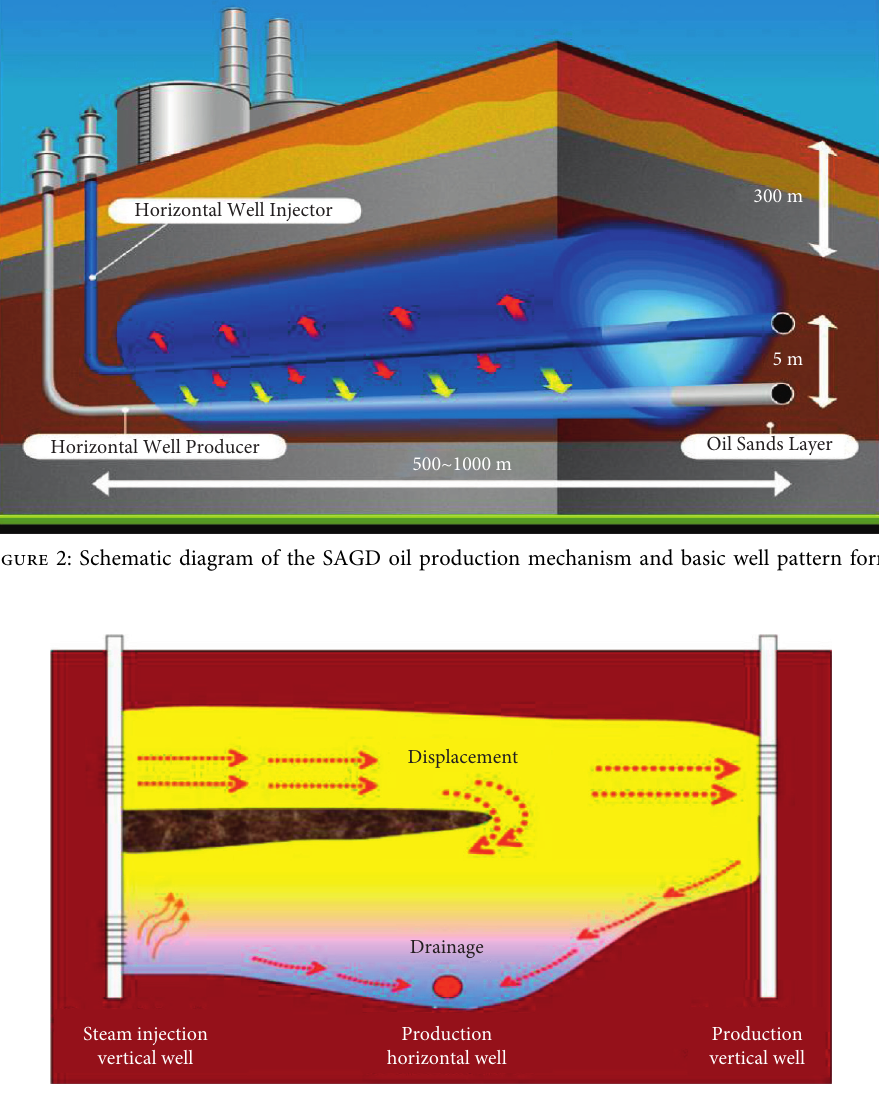
Figure 3: Innovation of the SAGD well pattern form.